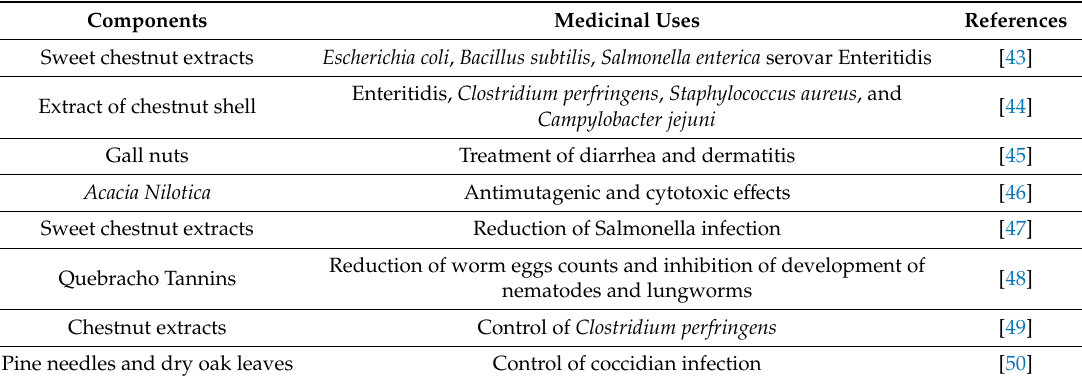
Table 2. Uses of tannins as medicinal sources and industrial